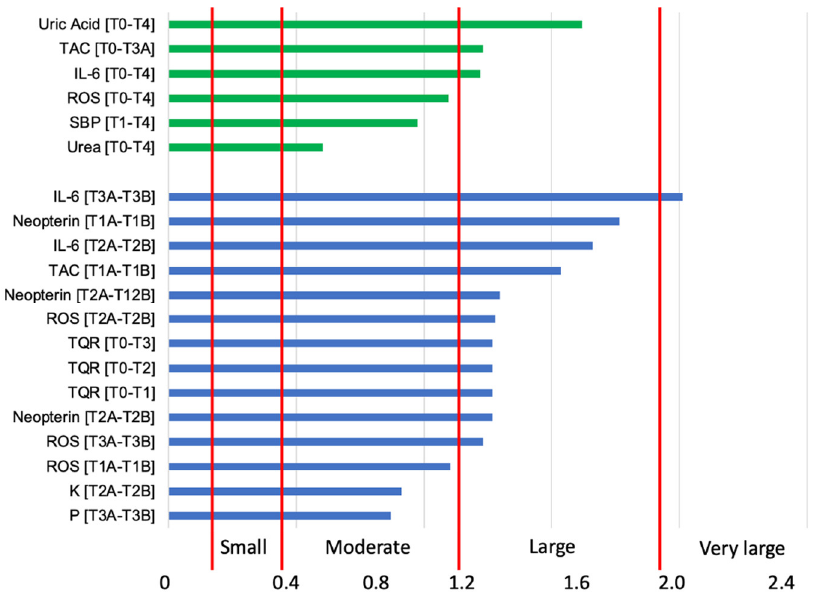
Figure 5. Relative difference among selected measures in athletes during season (green bars) and during training session (blue bars).